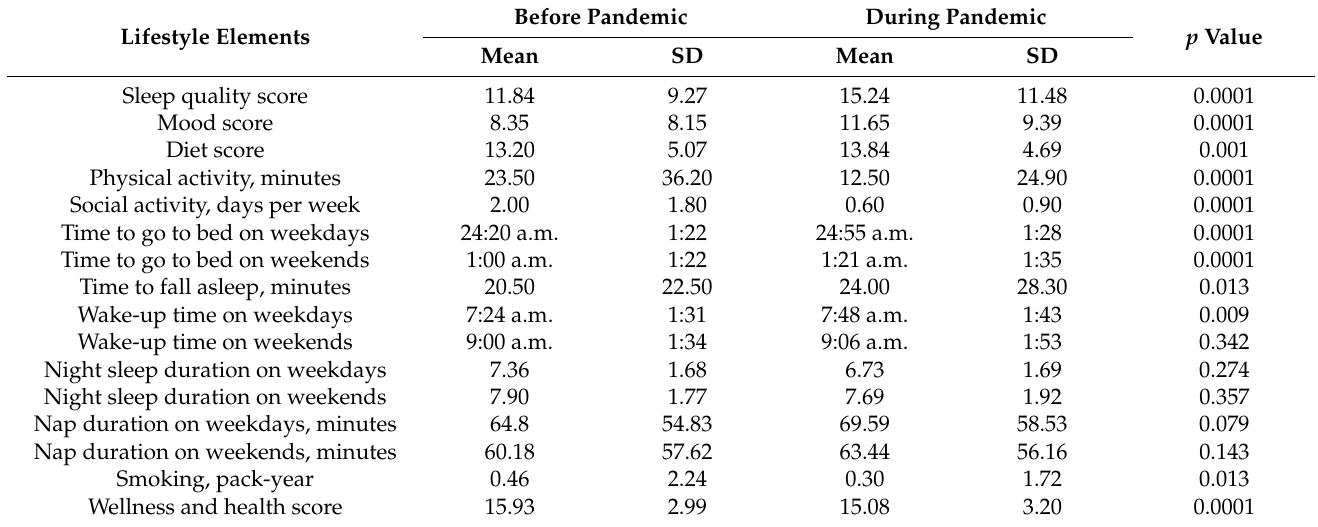
Table 2. Lifestyle characteristics of participants during the pandemic period compared with the pre-pandemic